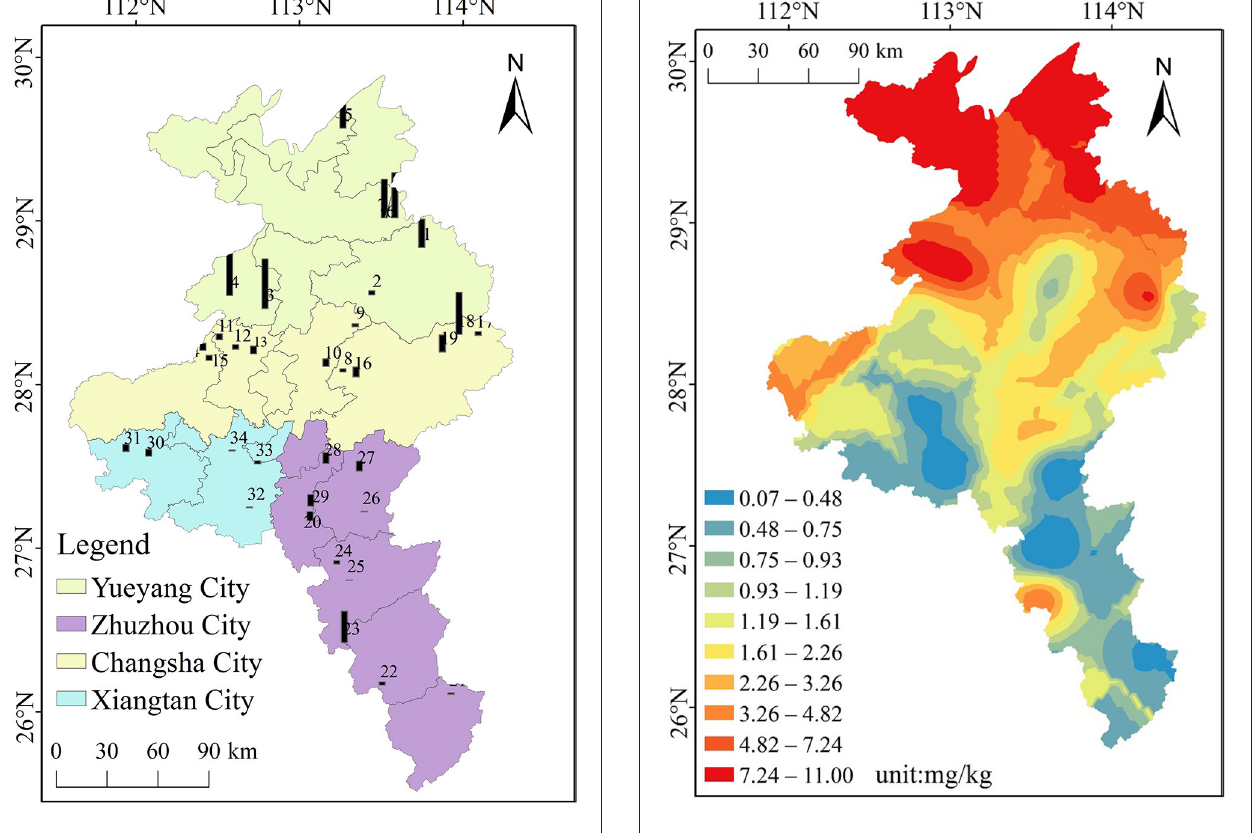
FIGURE 5 | Contents of Sb in different sampling sites. FIGURE 6 | Spatial distribution of the content of Sb on the surface of paddy